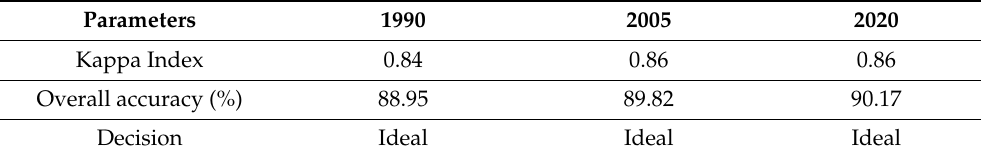
Table 1. Statistical validation of image-processing